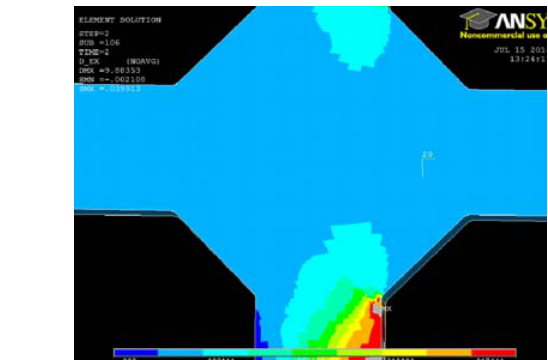
x at F min (u x =-1.2 mm).